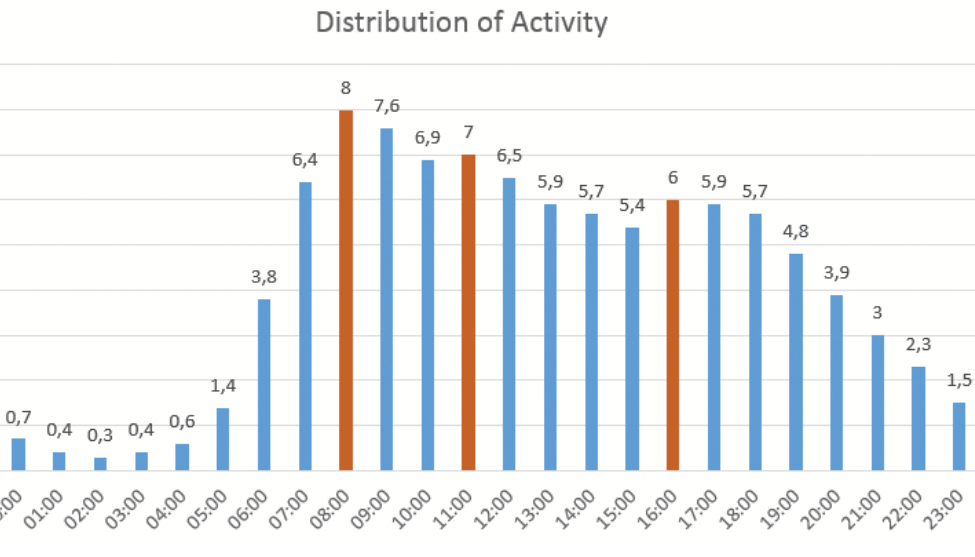
Figure 8. Distribution of events over a day in all households (relative percent) with clearly observable activity peaks in the morning, around noon and in the early